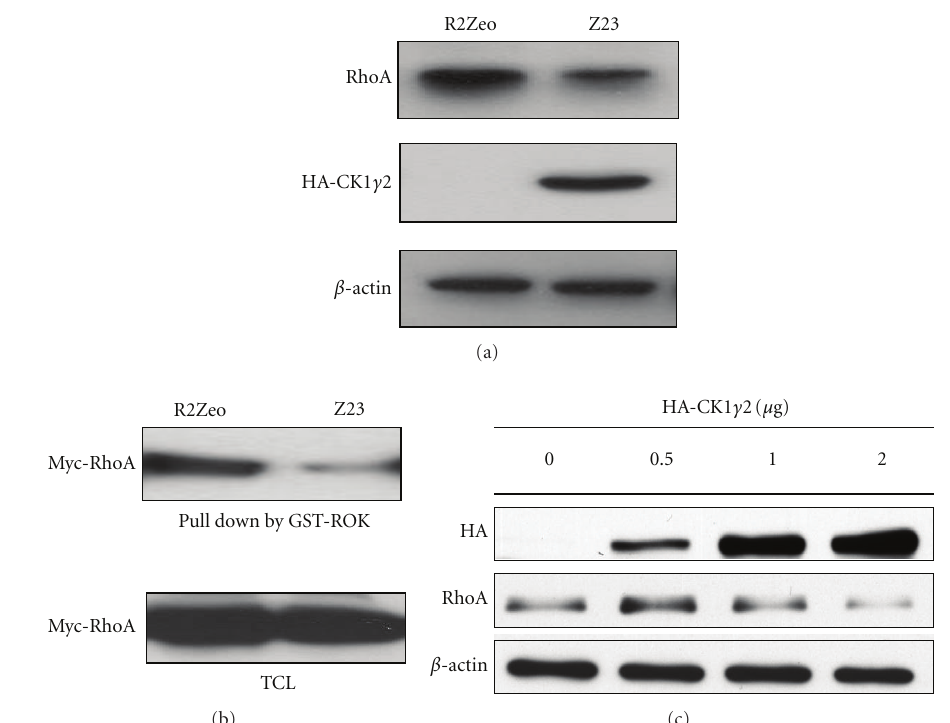
Figure 5: Overexpression of CKI γ 2 in fibroblasts reduces the levels of RhoA protein and RhoA activation. (a) Fibroblasts stably overexpressing CKI γ 2 (Z23) and control fibroblasts (R2Zeo) were analyzed for RhoA protein expression levels by Western Blot using equivalent amount of total cell lysate proteins. (b) Levels of activated Myc-RhoA (Myc-RhoA-GTP) were assessed following transient expression of MycRhoA in serum growing fibroblasts control (R2Zeo) or overexpressing CKI γ 2 (Z23) using pull down of equivalent amount of total cell lysate proteins with a GST fusion protein encoding the Rho-binding domain of Rhotekin. (c) Total cell lysates from fibroblasts transiently transfected with increasing amount of plasmid encoding HA-CKI γ 2 were subjected to Western Blot analysis with indicated